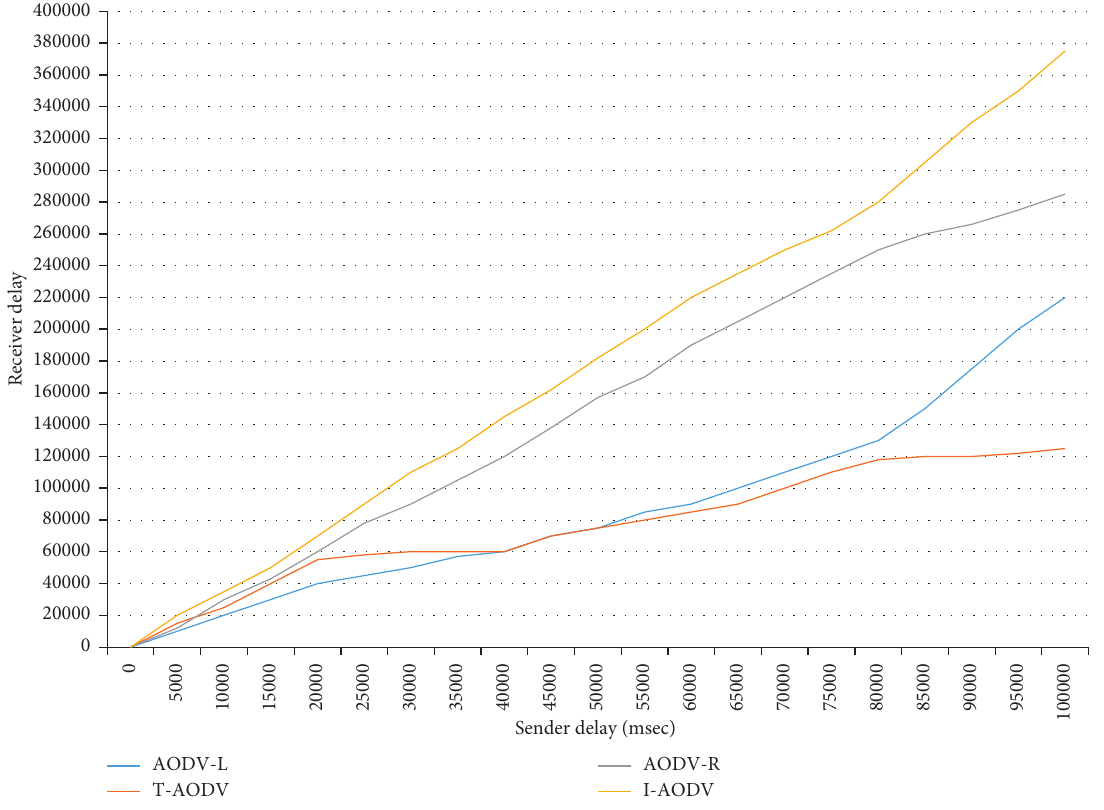
Figure 7: End-to-end delay of network.